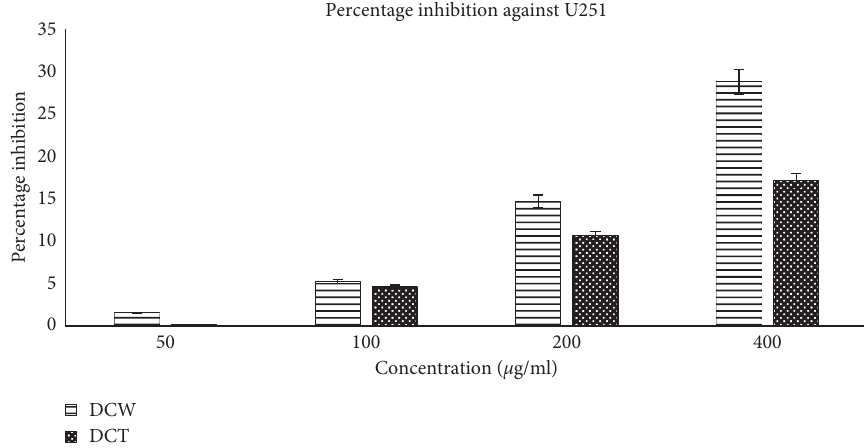
Figure 4: Percentage of inhibition of U251 cell proliferation by D. chryseum derived from DCW and DCT samples. Table 3: IC 50 values of the D. chryseum extract and cis -platin against HeLa and U251 cancer cell lines. Cell